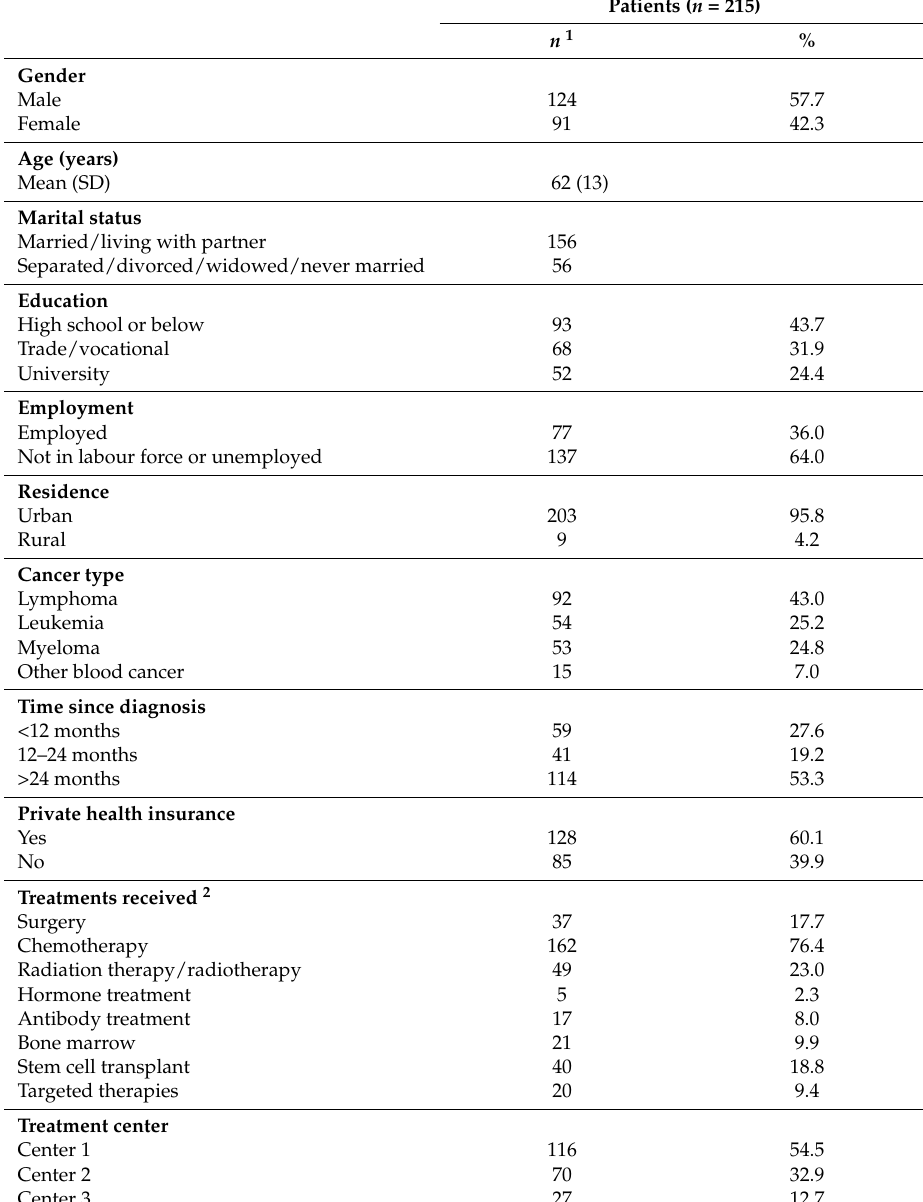
Table 1. Hematological cancer patients’